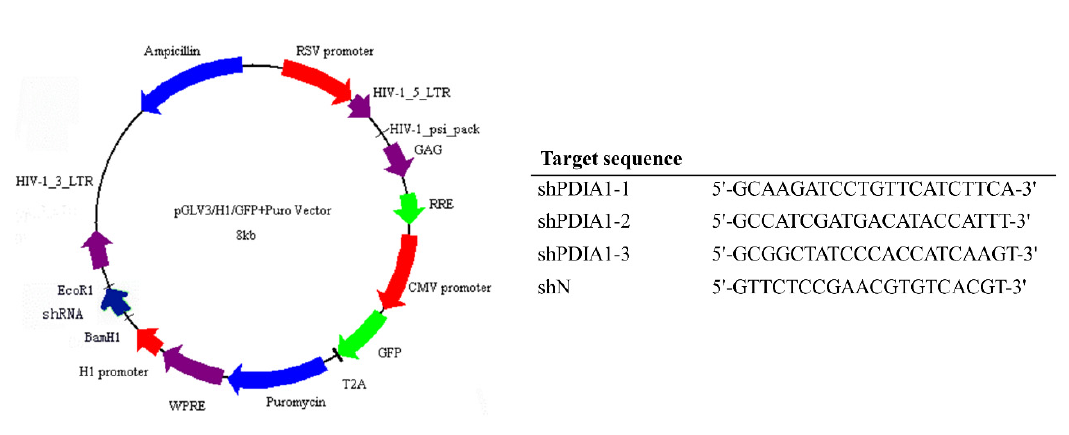
Figure 6. The scheme of lentiviral vector used for silencing of PDIA1 expression and sequences of short hairpin RNAs (shRNAs) cloned to the plasmid.